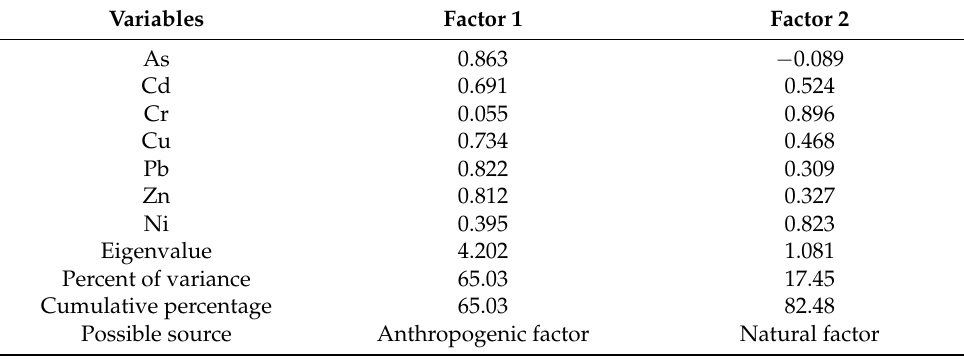
Table 1. Varimax-rotated factor loading (PCA) and identified sources of heavy metals in soils.